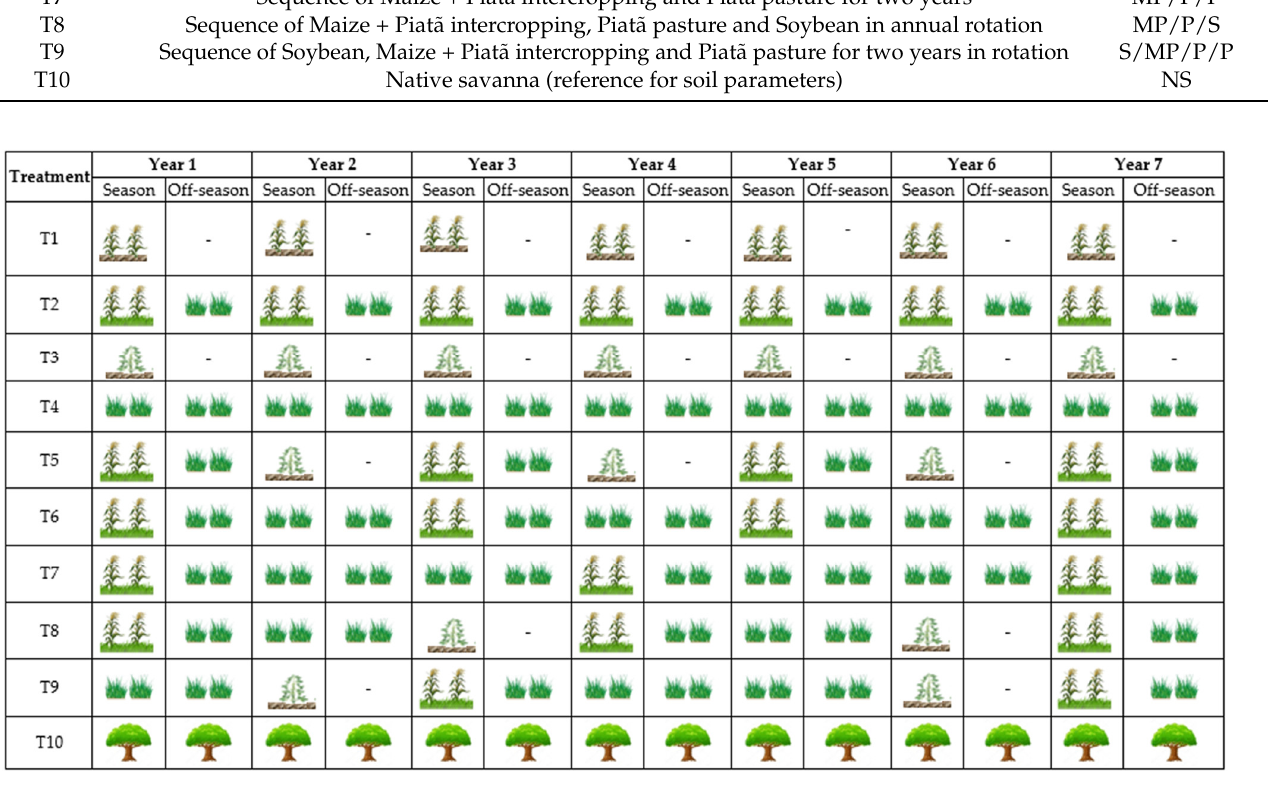
Figure 1. Crop sequence representation referring to the 9 treatments in the 7 agricultural